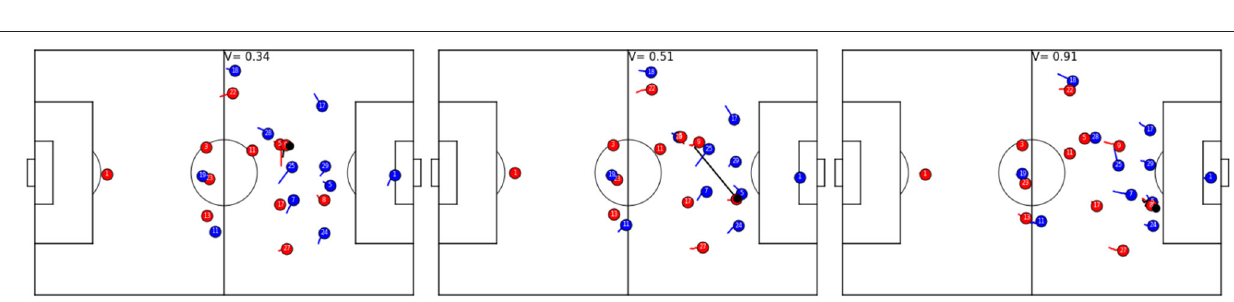
FIGURE 7 | Temporal development of the V for a passing action. Red is attacking from left to right. Player 9 is about to pass the ball to player 8 (Left) . There is no immediate pressure on player 9 and the V is 0.34. Player 8 receives the ball under heavy pressure by blue player 5, which yields V = 0.51 (Center) . Receiver 8 was able to retain possession of the ball and is dribbling into the dangerous area, reflected by V = 0.91 (Right)